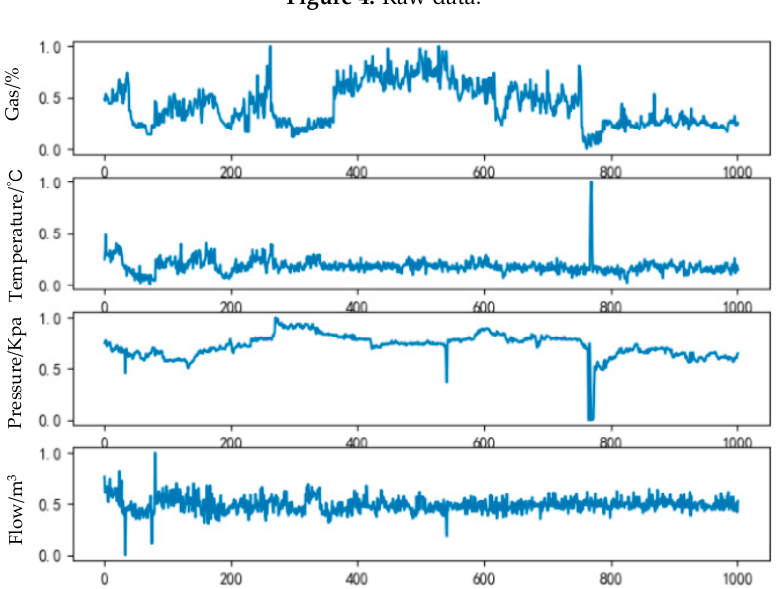
Figure 4. Raw data. Figure 4. Raw data.